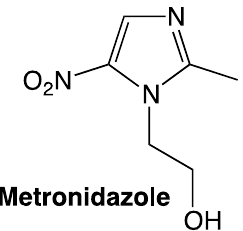
Figure 2. Metronidazole as a 5-nitroimidazole.